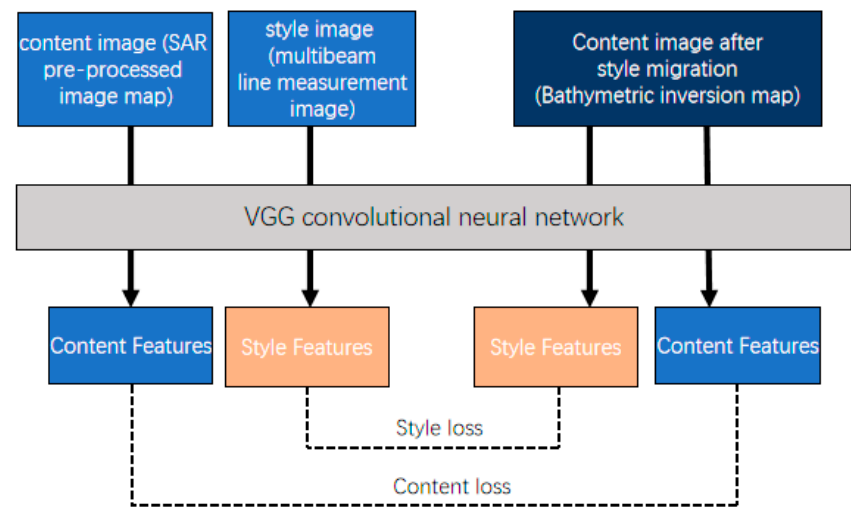
Figure 2. Overview of the model process.